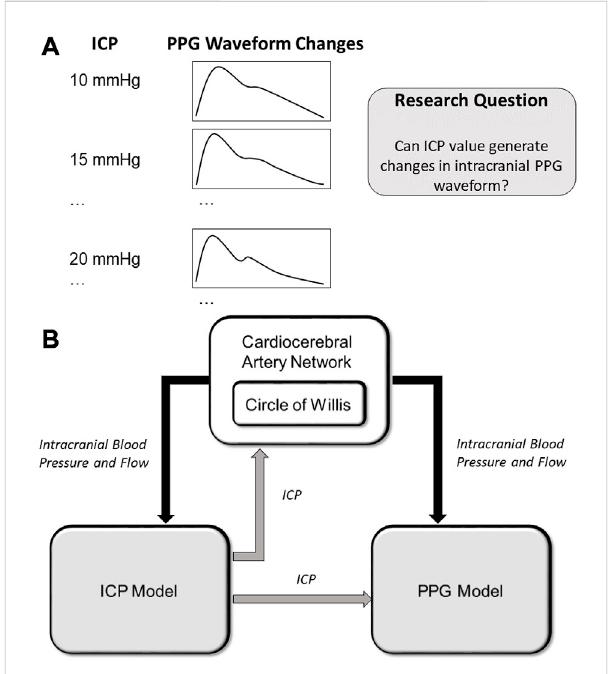
FIGURE 1 (A) Scienti fi c hypothesis of this paper: changes in ICP values can lead to PPG waveform changes which can be computationally simulated. (B) Structureofthecomputationalmodel.Thearrowsshow the data fl ows. ICP: intracranial pressure; PPG: